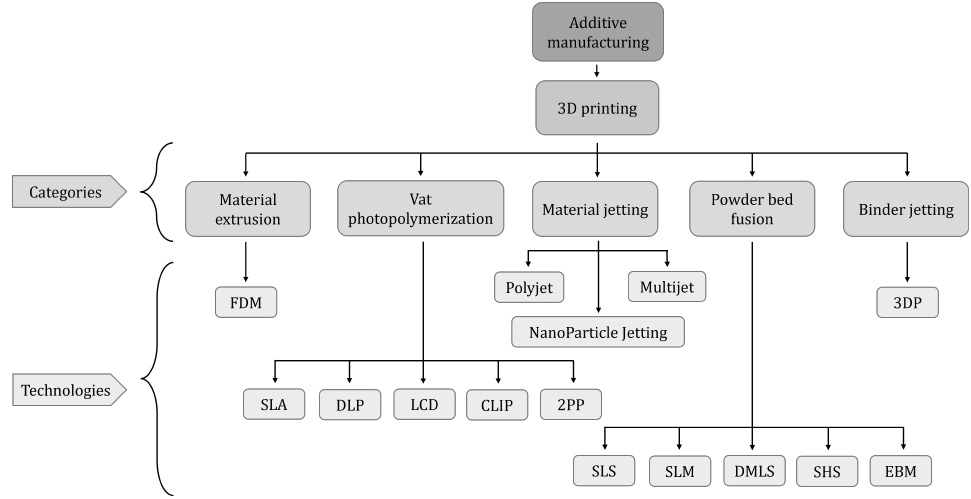
Figure 5. Five 3D printing categories with their respective